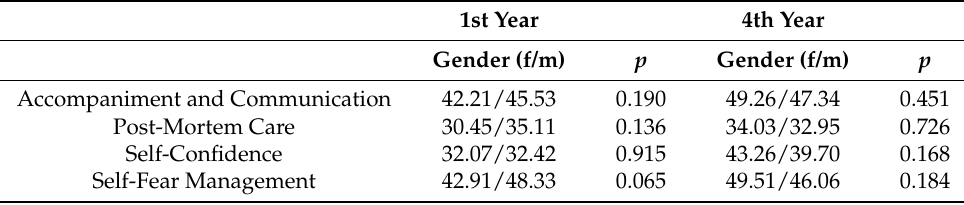
Table 3. Gender comparison.